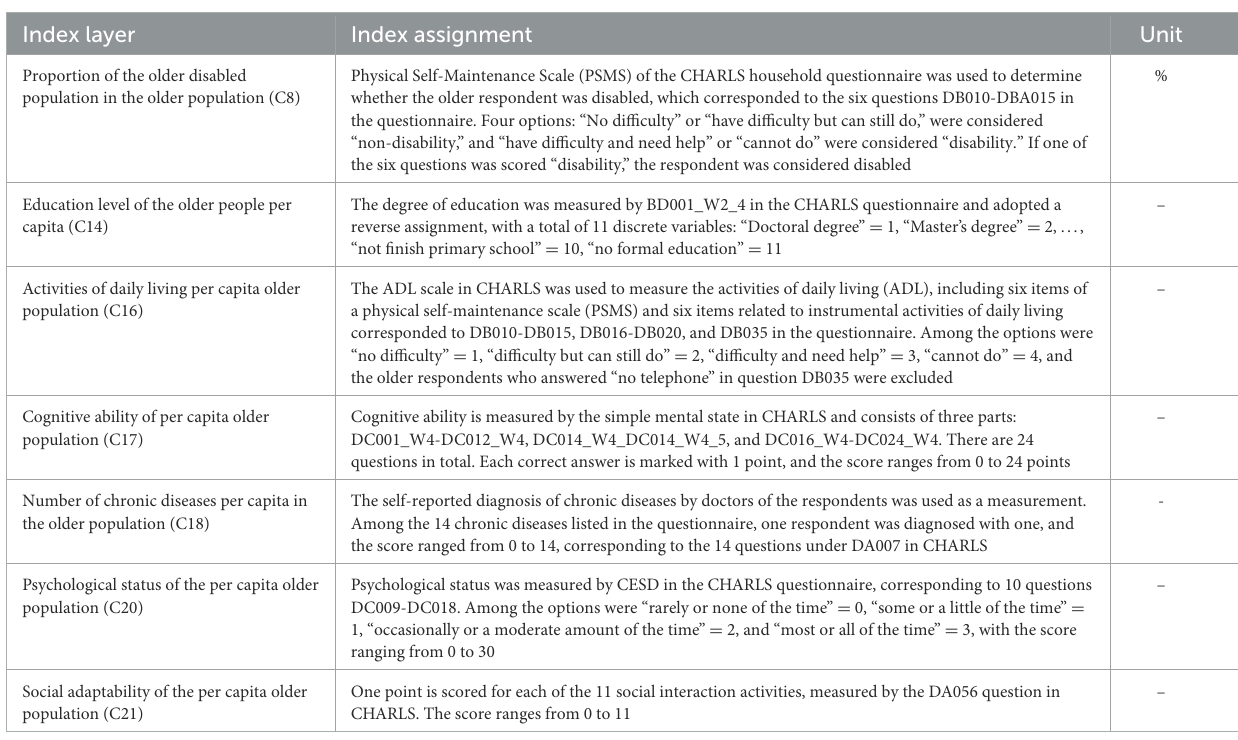
TABLE 3 Partial measure index of social disability risk and its